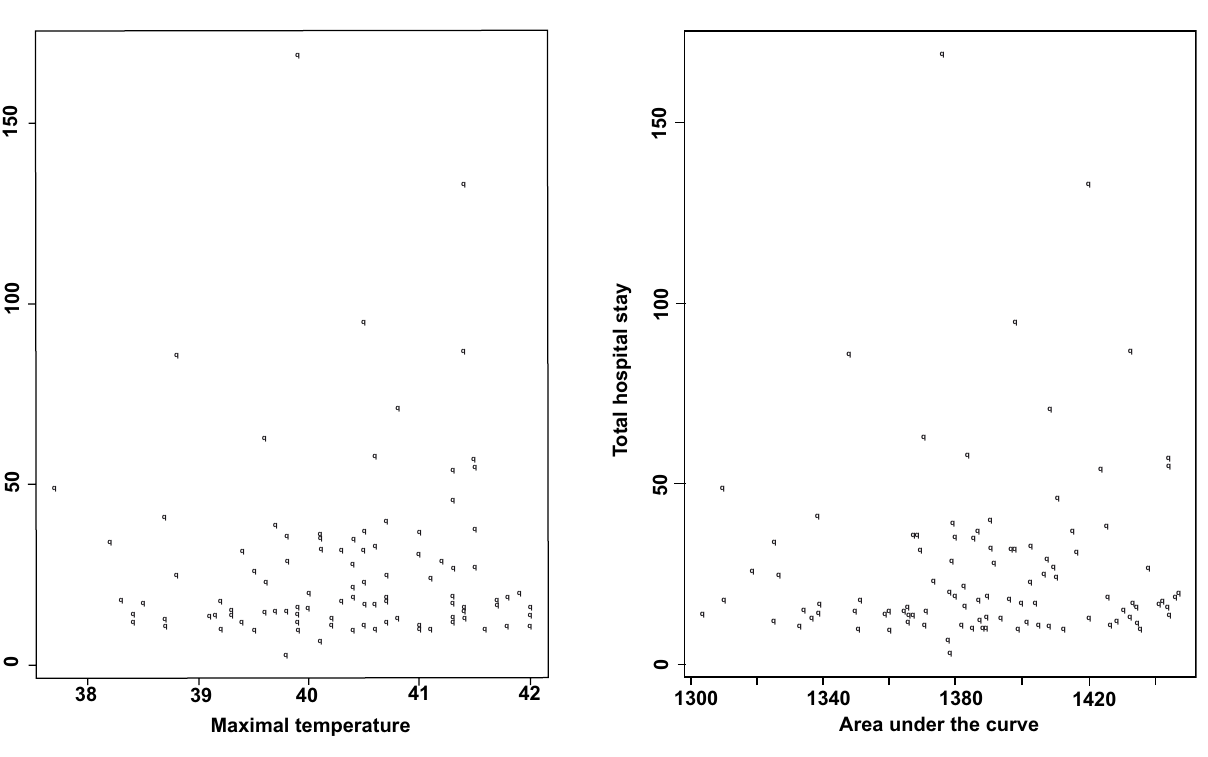
Figure 10. Total hospital stay (days) versus area under the curve ( ° C*minutes). Scatterplot showing the relation between hospitalization duration and